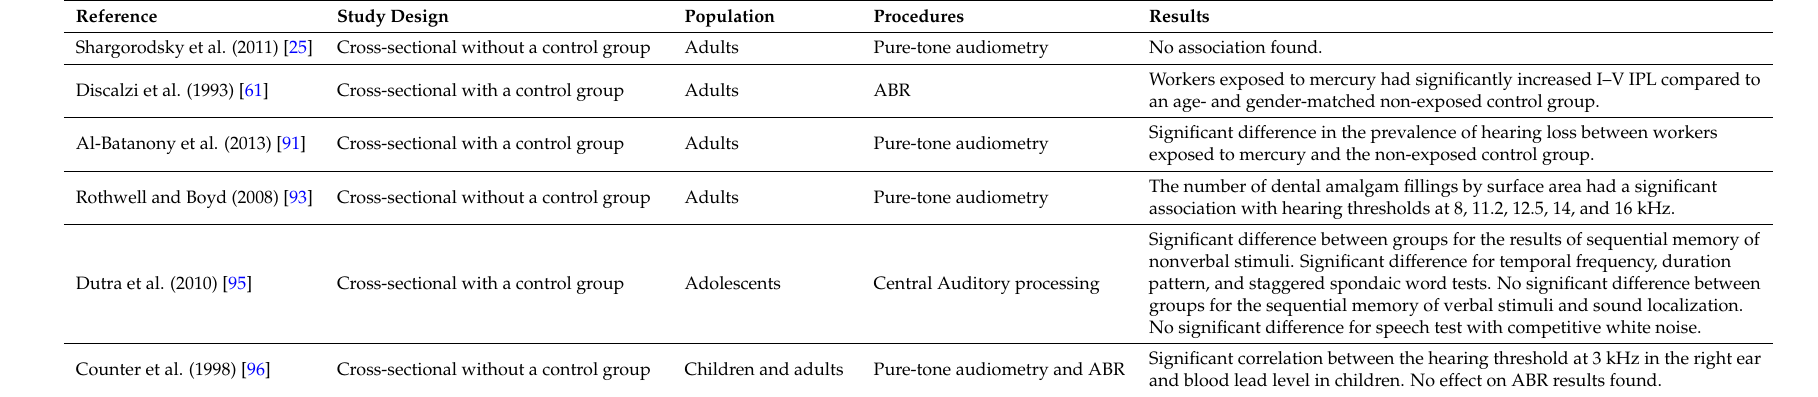
Table 4. Summary of studies investigating the effects of mercury exposure in children and